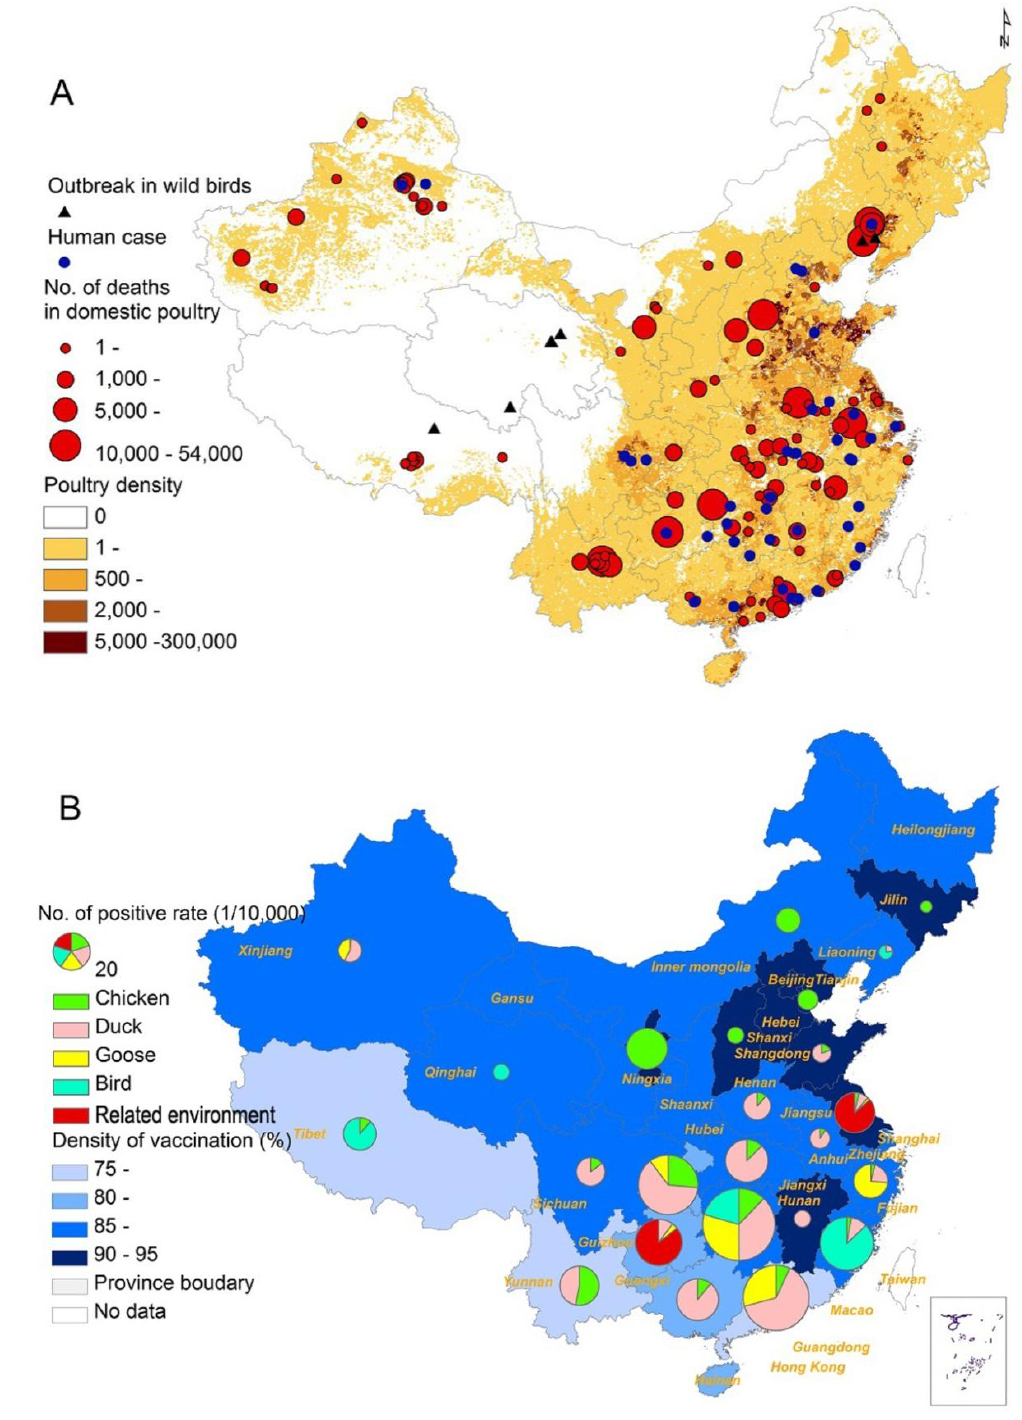
Figure 2. Spatial distribution of HPAI H5N1in mainland China, 2004–2012; ( A ) Spatial distribution of HPAI H5N1 outbreaks in wild bird, human cases and number of deaths in domestic poultry. Black triangle indicates the location of HPAI H5N1 outbreak in wild birds, blue dot indicates the location of human case, and red dot indicates the location and number of deaths of domestic poultry. Density of poultry is indicated by color gradient; ( B ) Positive rate in surveillance from difference species. Light apple, rose quartz, autunite yellow, beryl green and red pies indicate the positive rate in chicken, duck, goose, wild birds and related environment, and density of vaccination was indicated by blue